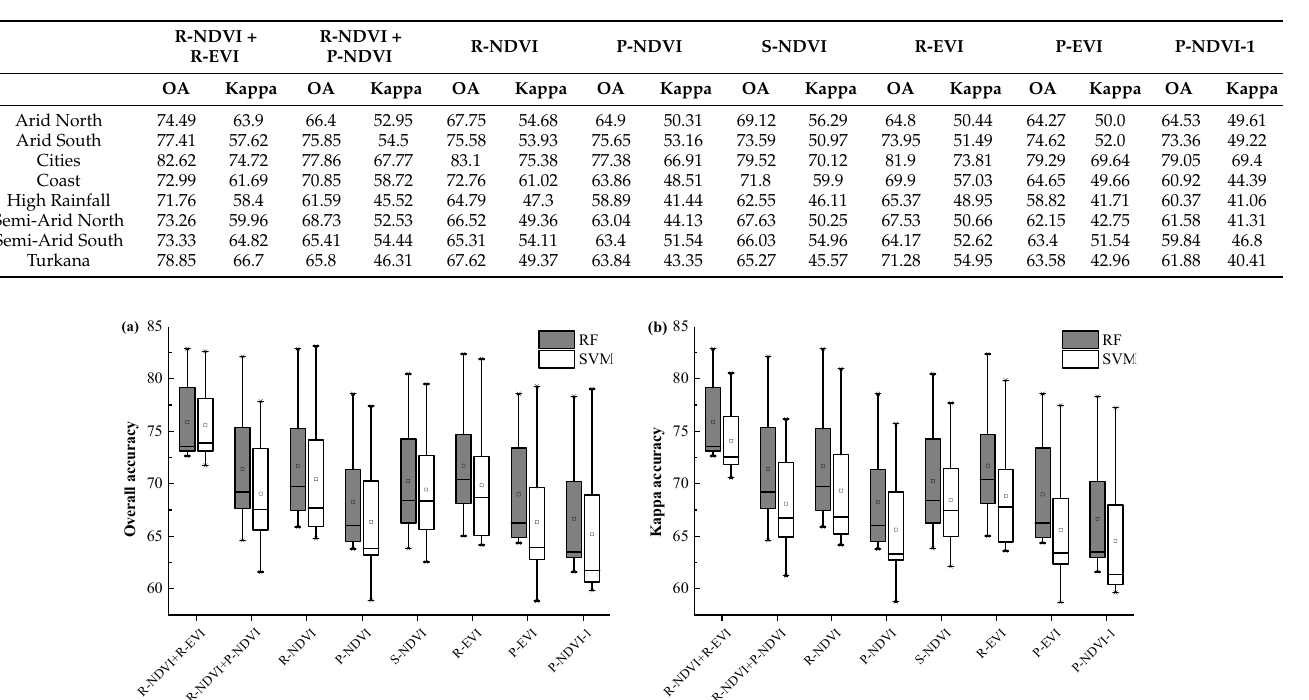
Table 3. Accuracies (Overall Accuracy and Kappa Accuracy) were achieved for SVM in different AEZs and different datasets.